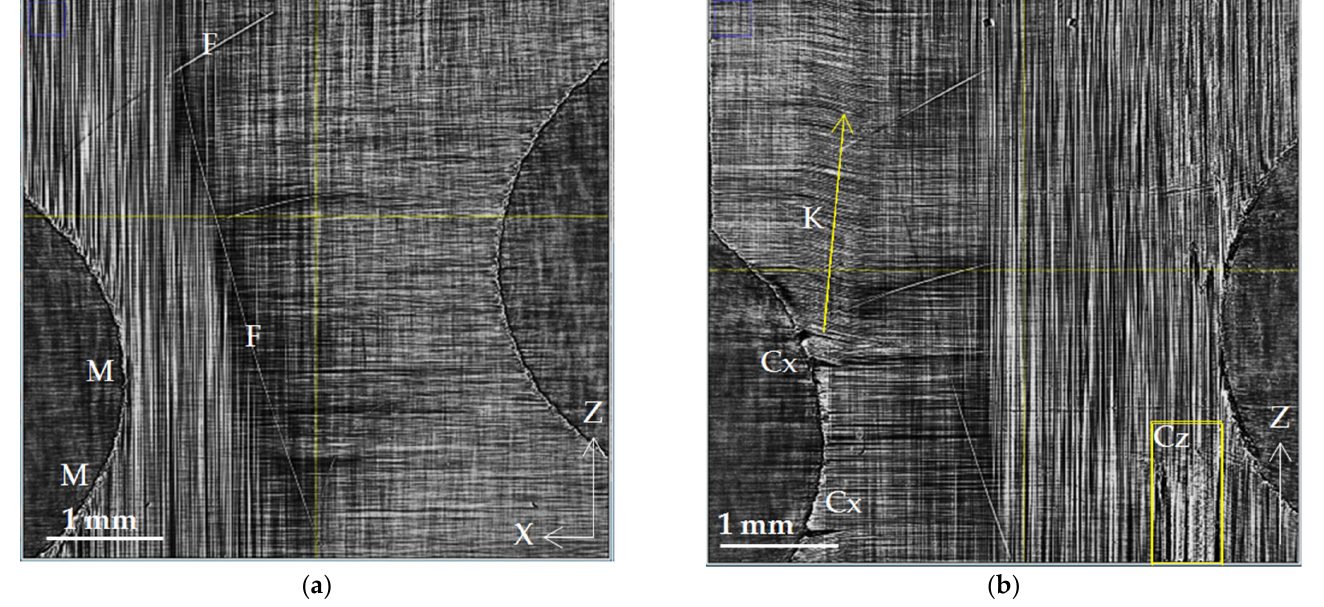
Figure 4. Microstructure of cross-ply CFR plastic at the interface of adjacent [0/90] layers: ( a ) initial state, 38 MPa; ( b ) loaded state, 865 MPa. The designations are M—mechanical damage; F—individual filament; Cx—crack spreading along the X-axis; Cz—crack along the Z-axis; and K—kinking of the fiber package.